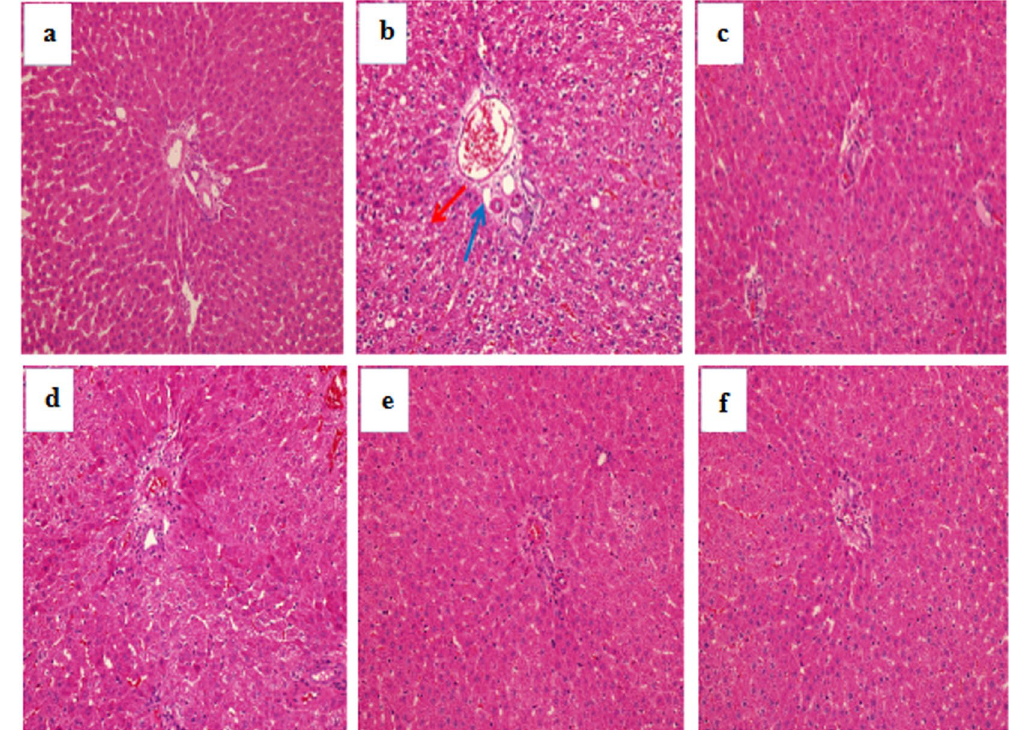
Figure 5. Effect of EA treatment on liver histopathological alterations (H&E staining, magnification 200 × ). ( a ) Blank control group; ( b ) D-gal model group; ( c ) D-gal + VE150 mg/kg; ( d ) D-gal + EA50 mg/kg; ( e ) D-gal + EA100 mg/ kg; ( f ) D-gal + EA150 mg/kg. Red arrow indicated apoptosis and necrosis; Blue arrow indicated inflammatory